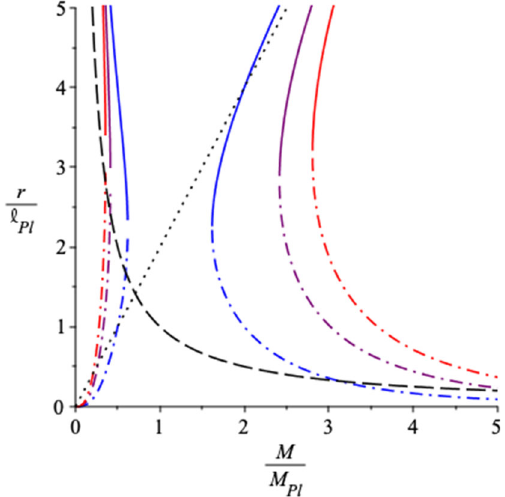
Fig. 9 The outer (solid) and inner (dash-dot) horizons for the GUP- Kerr black hole with β = 2 and n = 5 (blue), 8 (purple) and 10 (red), showing the mass gaps for n > 4. The dotted line is the Schwarzschild radius, r = 2 M / M 2 , and the dashed curve is the Compton Pl